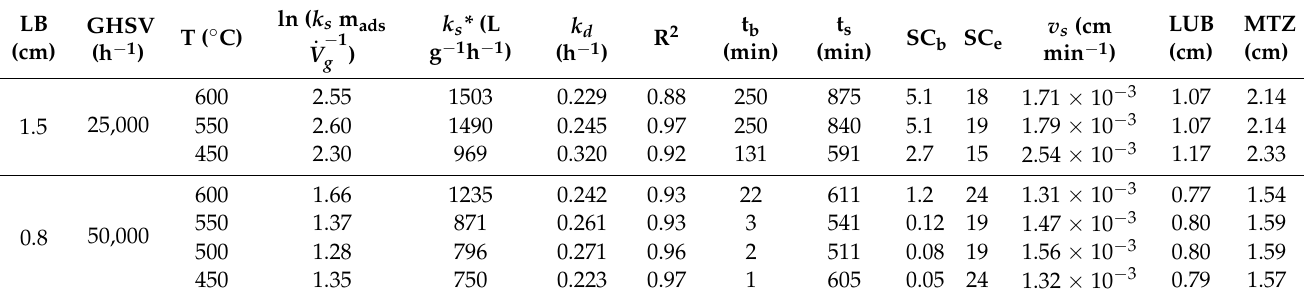
Table 5. Outputs from breakthrough curves, kinetic constant, and sizing of LB.